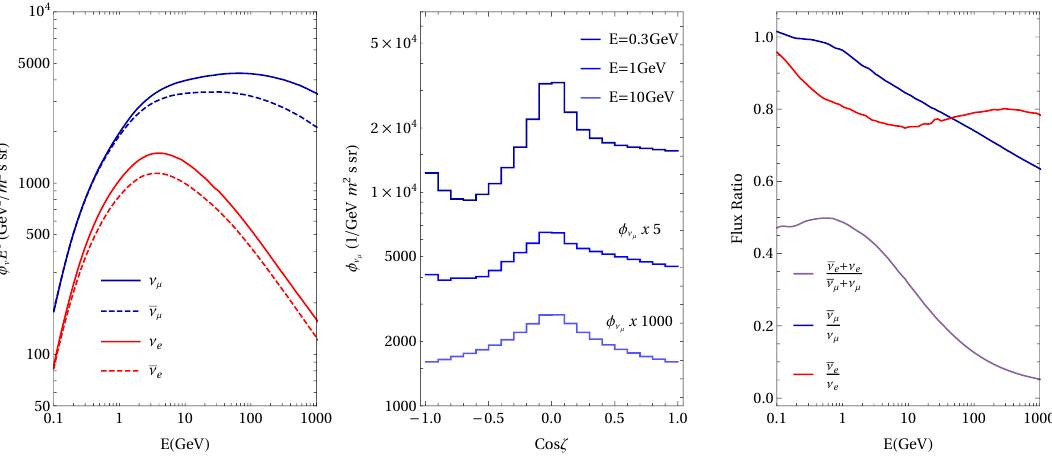
Figure 11 . Left : atmospheric neutrino fluxes as a function of the neutrino energy for ν µ (blue), ν µ (blue dashed), ν (red), ν (red dashed). Middle : zenith dependence of atmospheric neutrino flux e e for neutrino energies of 0.3 GeV (dark blue), 1 GeV (blue) and 10 GeV (light blue). Right : flux ratios for ν + ν + ν (purple), ν (blue), and ν µ µ /ν e e µ /ν µ e /ν e